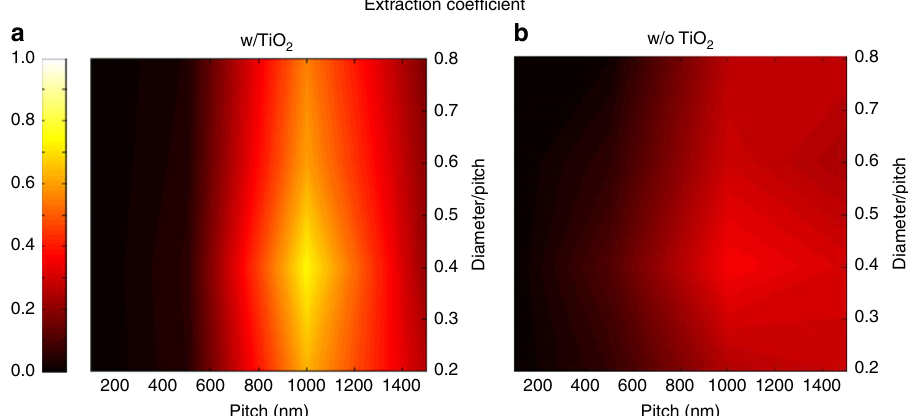
Fig. 3 Light extraction simulation. Two-dimensional (2D) contour of the extraction coef fi cient for AAM devices a w/ and b w/o TiO 2 . Different pitches and diameter/pitch ratios were simulated. For device w/o TiO 2 , the AAM channel was fi lled with air